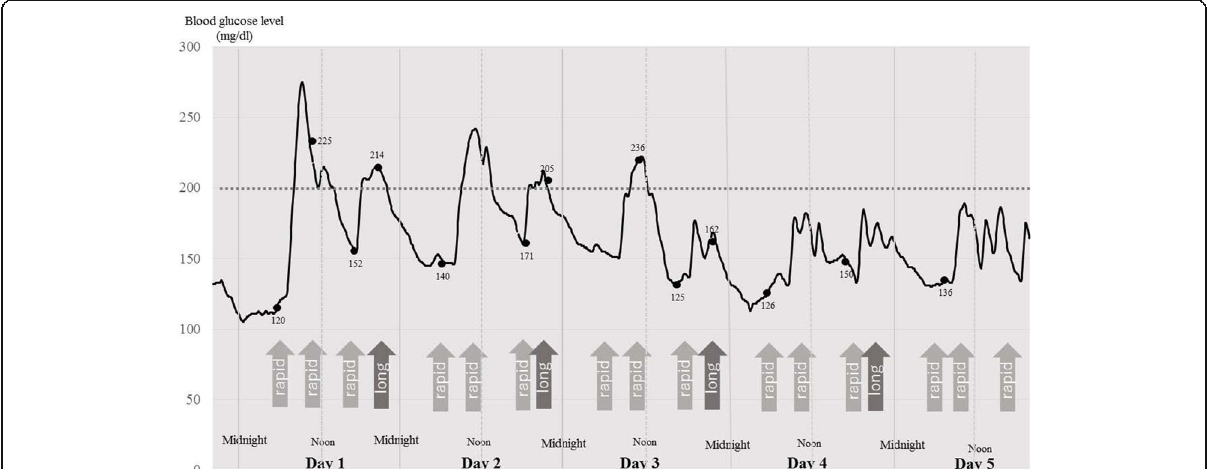
Fig. 2 Continuous blood glucose trace for Patient 2. Postoperative blood glucose in a 73-year-old woman with diabetes in whom a right total hip arthroplasty (THA) had been performed. X-axis, postoperative day; Y-axis, blood glucose concentration (mg/dl). Black spots, blood glucose concentrations measured using SMGB. Each number is the blood glucose concentration (mg/dl) at that time point. Arrow (rapid), the administration of rapid-acting insulin; arrow (long), the administration of long-acting insulin